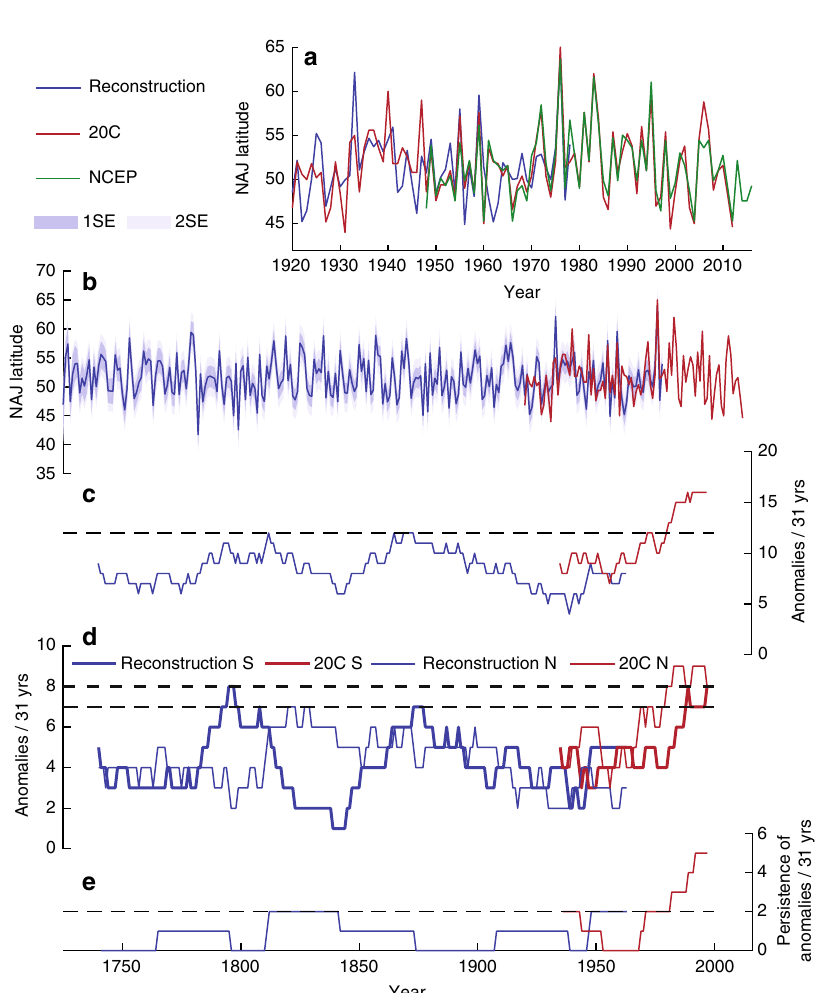
Fig. 3 Summer NAJ reconstruction and variance. The reconstruction of the latitudinal position of the August NAJ was scaled and calibrated against NAJ position calculated based on twentieth century reanalysis data and explains 40% of its variance over the period of overlap (1920 – 1978; a ). The NCEP/ NCAR reanalysis data (1948 – 2016) are plotted for comparison in a . The full NAJ reconstruction (1725 – 1978) including combined error estimations is plotted in b . Running 31-year window number of NAJ anomalies ( c ), number of northern (N) and southern (S) NAJ anomalies ( d ), and persistence of anomalies ( e ) are plotted on the central year of the window for reconstructed (blue) and 20C Reanalysis (red) NAJ time series. Anomalies are de fi ned as years when NAJ > 1 stdev, with standard deviation calculated based on a merged time series of reconstructed (1725 – 1919) and 20C Reanalysis (1920 – 1978) NAJ values. Horizontal dashed lines in c – e represent the highest 31-year values over the reconstruction period (1725 –